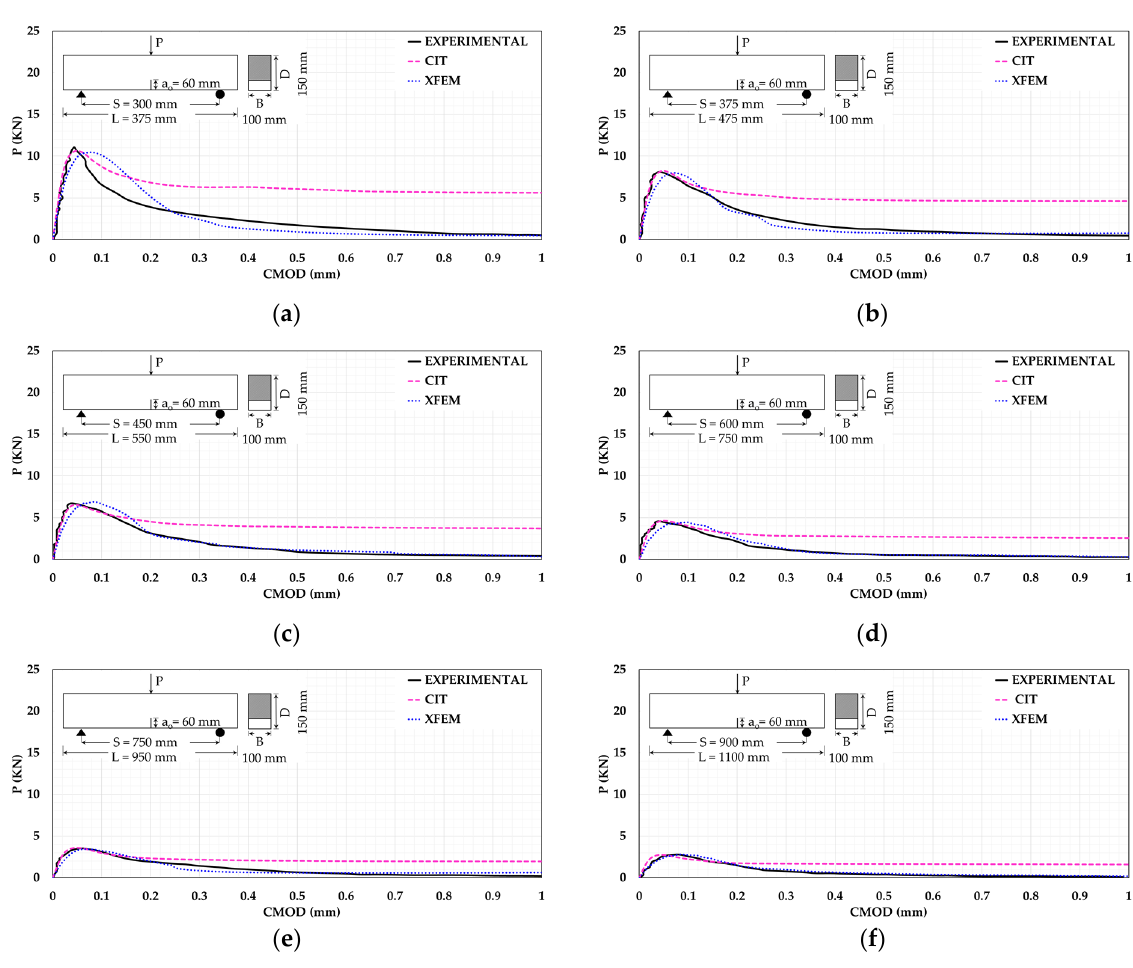
Figure 5. The P-CMOD relationships for beams ( a ) T2; ( b ) T2.5; ( c ) T3; ( d ) T4; ( e ) T5; ( f )